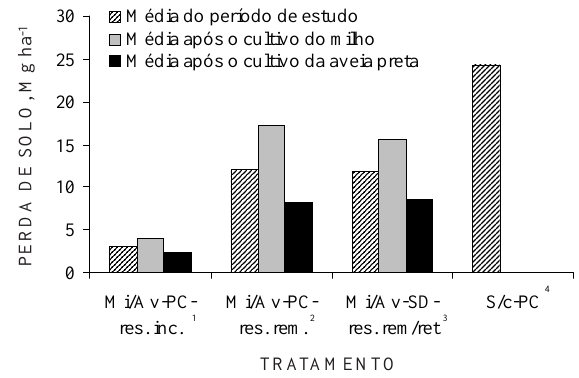
Figura 5. Valores médios da perda total de solo do período de estudo, após o cultivo do milho e após o cultivo da aveia preta ( 1 Milho/aveia preta, preparo convencional, resíduo cultural incorporado; 2 milho/aveia preta, preparo convencional, resíduo cultural removido; 3 milho/aveia preta, semeadura direta, resíduo cultural removido e retornado; 4 sem cultivo, preparo